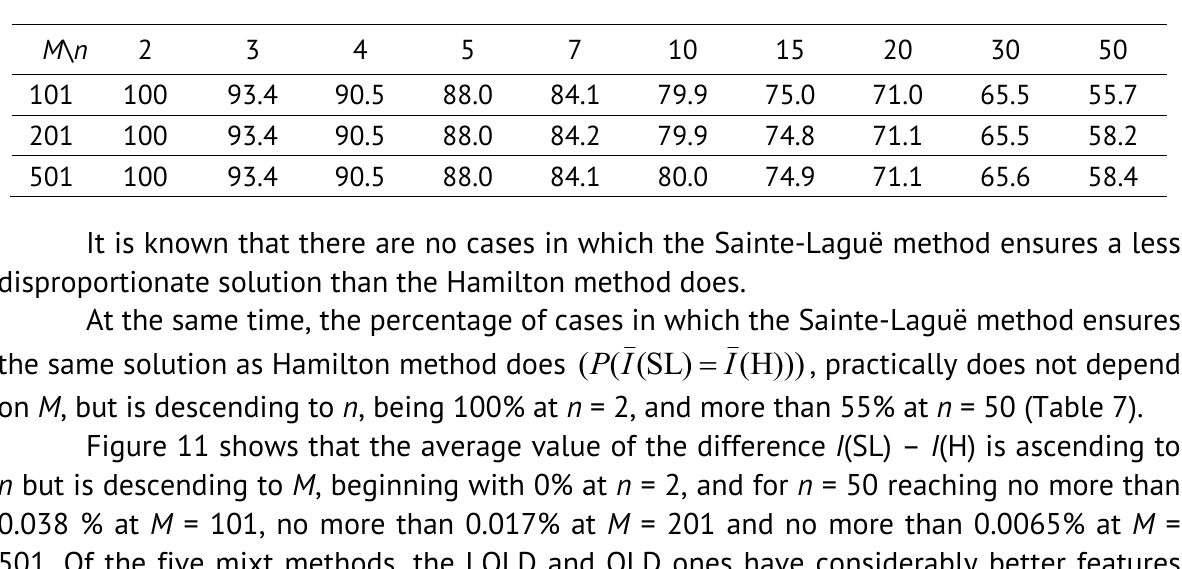
of cases in SL=H